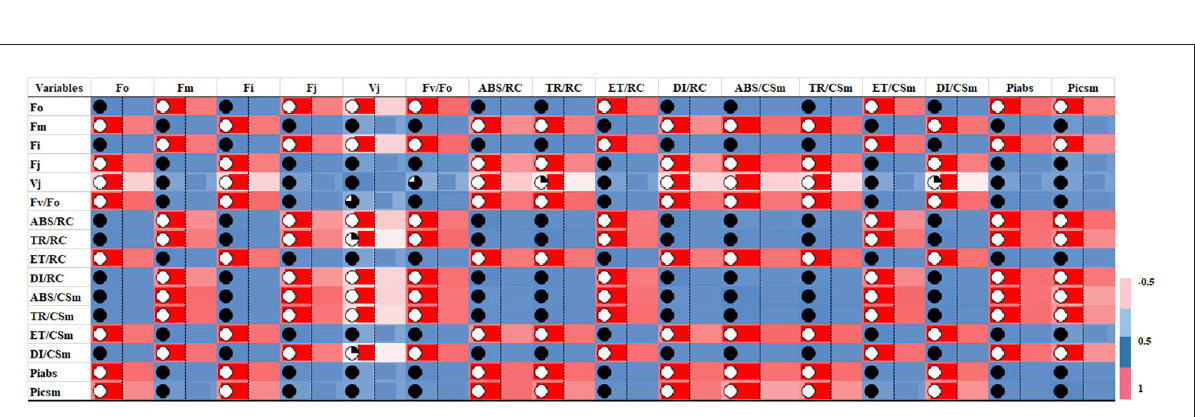
FIGURE13 Heat map of correlation of chlorophyll fluorescence parameters showing the interrelationship between chlorophyll fluorescence parameters.